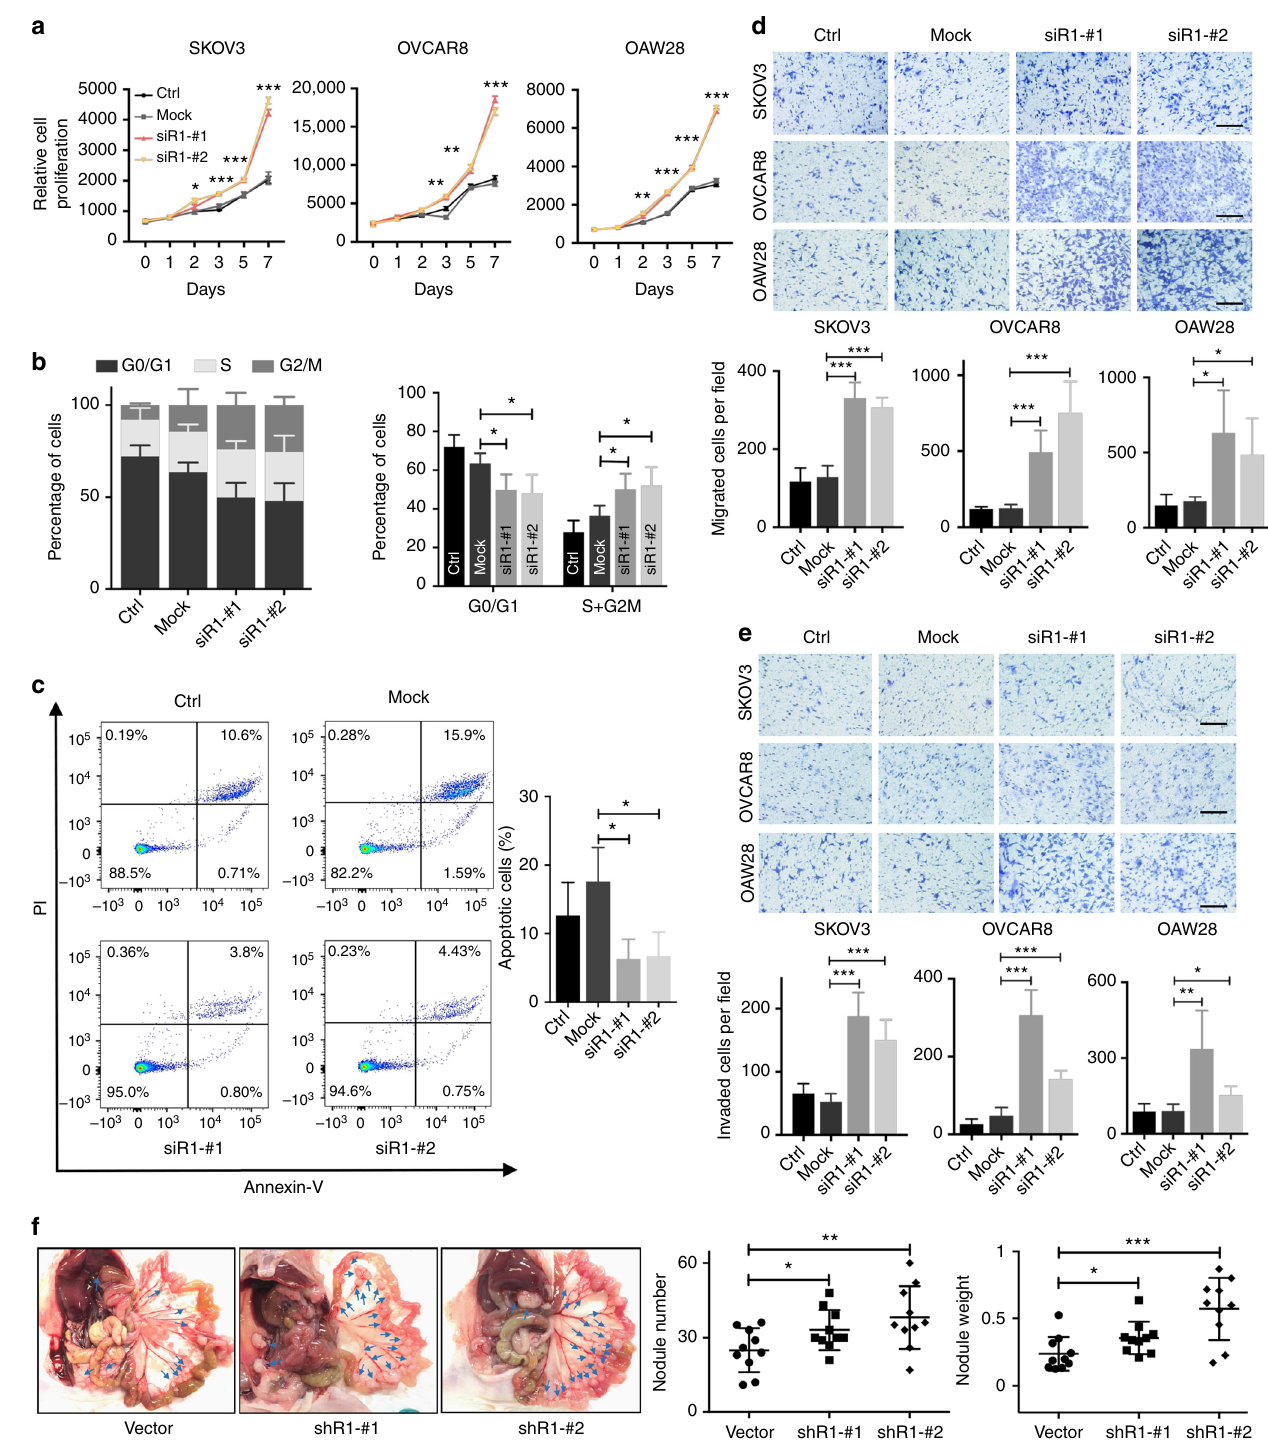
Fig. 1 PIK3R1 loss promotes ovarian cancer tumorigenic phenotypes in vitro and in vivo. a Ovarian cancer cells (SKOV3, OVCAR8, OAW28) were transfected with siRNA for 24 h before cell seeding. Cell viability was measured over 7 days. b Synchronized SKOV3 cells were transfected with siRNA for 48 h before cell cycle analysis. c Transfected SKOV3 cells were cultured in FBS-free medium 48 h before apoptosis assay. d , e Representative images (upper) and mean numbers of migrated ( d ) or invaded ( e ) ovarian cancer cells (SKOV3, OVCAR8, OAW28) of fi ve fi elds at magni fi cation of 100 × (lower). Scale bar, 200 μ m. f SKOV3 cells stably expressing PIK3R1 shRNA or empty vector were intraperitoneally injected into nude mice ( n = 10) for 5 weeks. Representative images showing tumor nodules indicated by blue arrows (left), and total nodule weight and number are shown (right). Error bars represent SD. * p < 0.05; ** p < 0.005; *** p < 0.001 compared with mock or vector using t